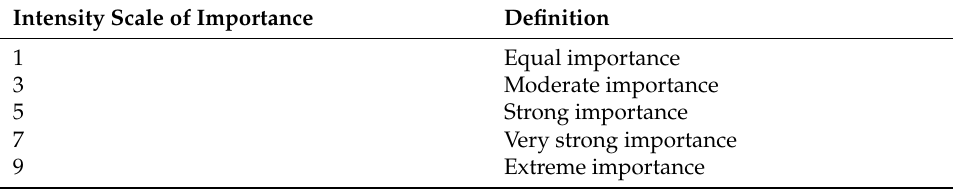
Table 3. Saaty’s